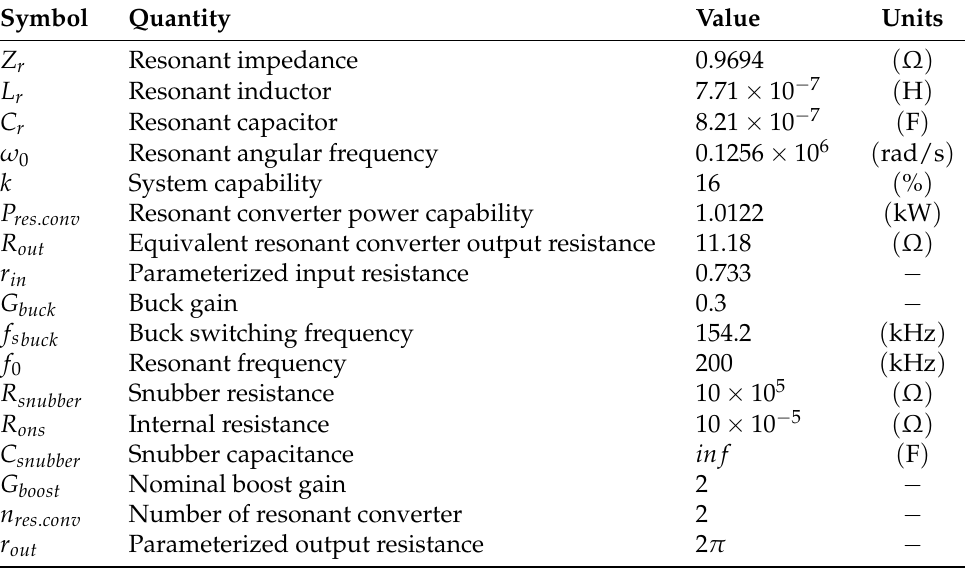
Table 1. Design and simulation data.